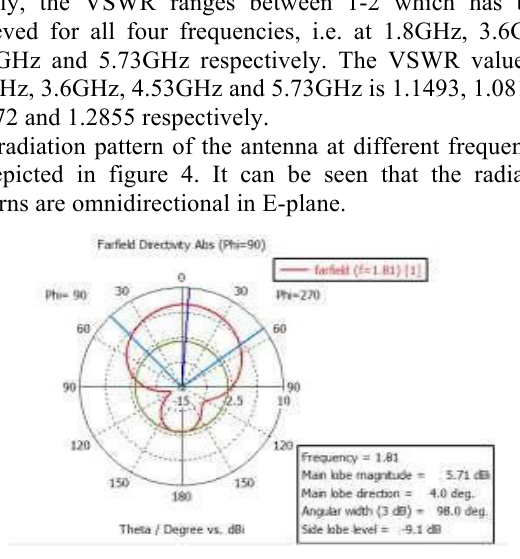
Figure.4.1: Far-field radiation pattern for 1.8GHz